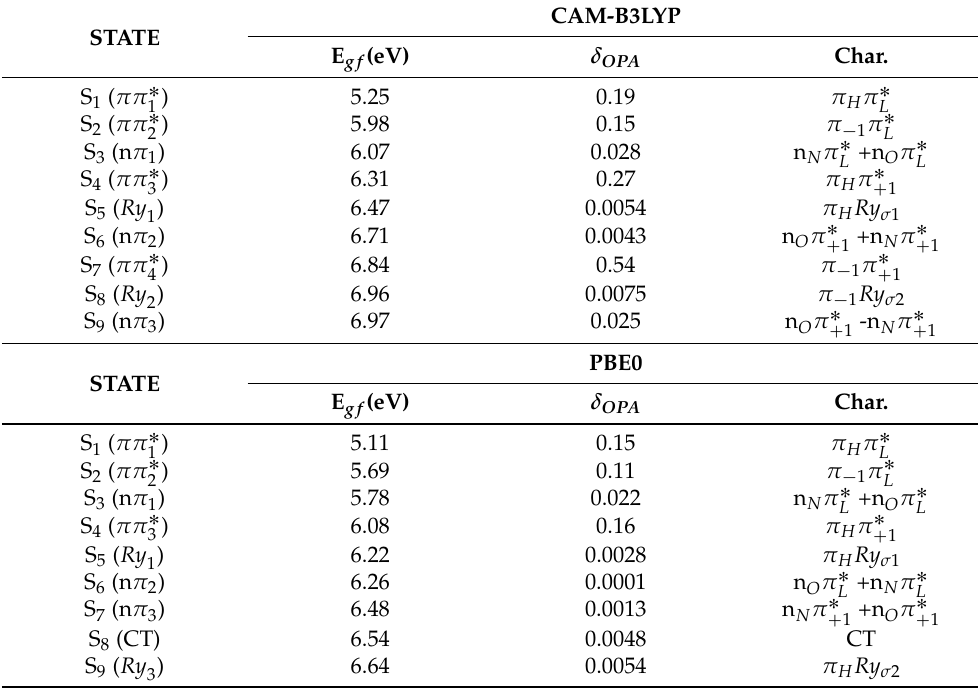
Table 2. Vertical excitation energies E gf (eV) and oscillator strengths ( δ OPA ) of the first nine excited states for cytosine ¨ 6H 2 O( C 1 symmetry point group) in water, calculated by CAM-B3LYP and PBE0, with the 6-311+G(d,p) basis sets in